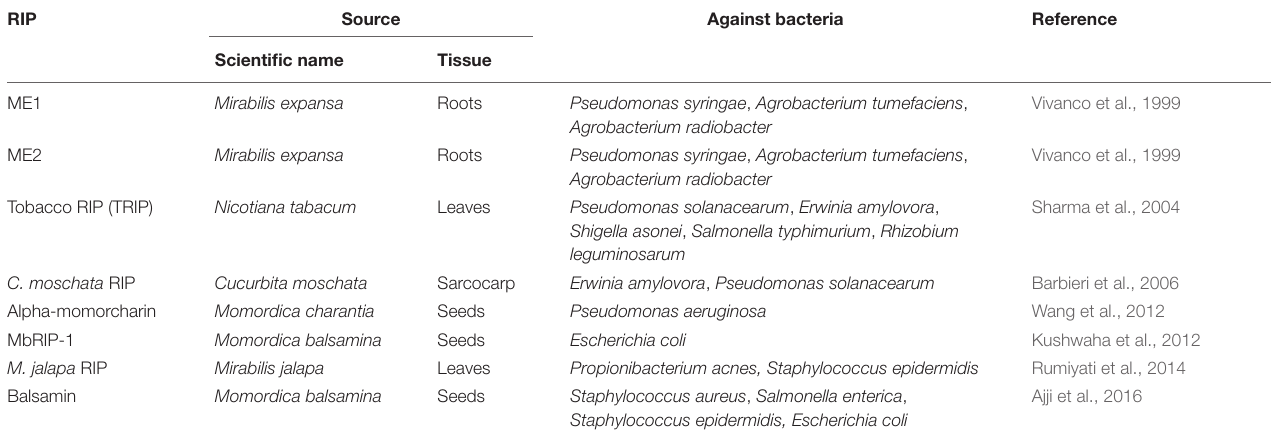
TABLE 1 | The role of different source ribosome-inactivating proteins (RIPs) in defense against bacteria.